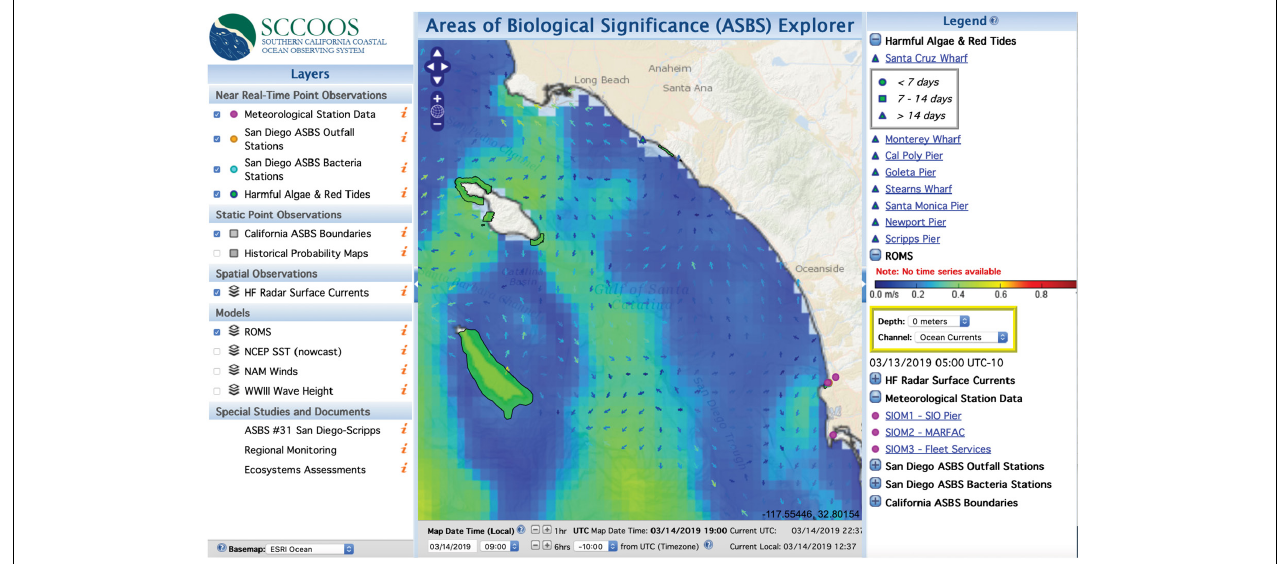
FIGURE 7 | SCCOOS Areas of Biological Significance (ASBS) Explorer tool provides users with a comprehensive interactive map showing critical coastal areas in California along with ocean observations. Image capture from March 14, 2019, is layered with the Regional Ocean Model System that shows ocean currents at 20 m depth, High Frequency Radar surface currents, harmful algae and red tides from harmful algal bloom monitoring stations, and the California ASBS boundaries. Meteorological station (pink circle), piers (blue triangles), and outfall stations can also be accessed through the tool. The ASBS Explorer is intended to help managers and the public monitor impacts on ASBS locations in California, specifically the San Diego metropolitan region. Image courtesy of